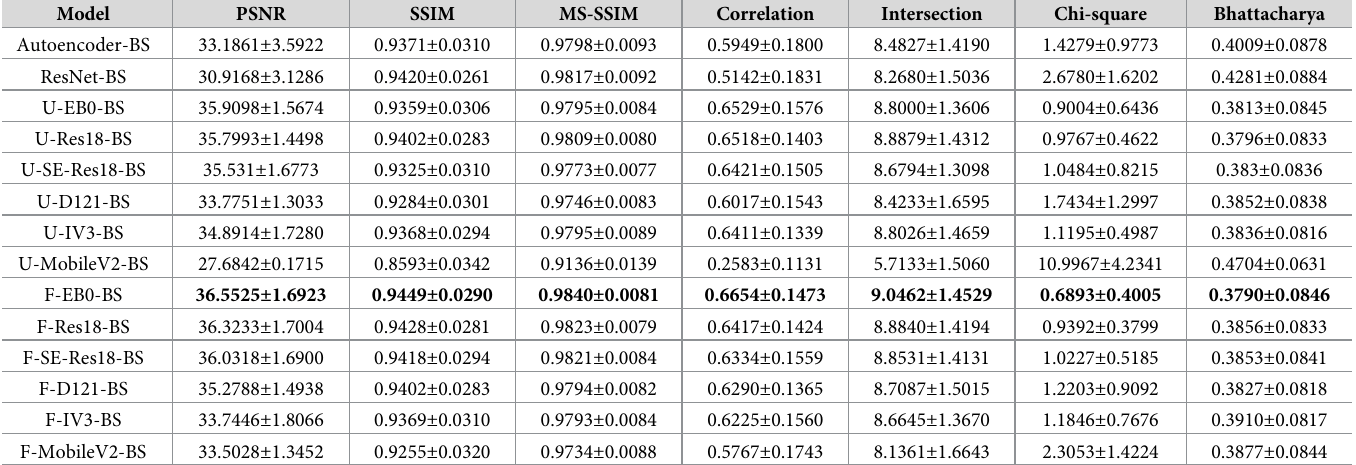
Table 2. Performance achieved by the proposed bone suppression models using the NIH-CC-DES-Set 1 test set. The values are given in terms of mean ± standard deviation. The best performances are denoted by bold numerical values in the corresponding columns.